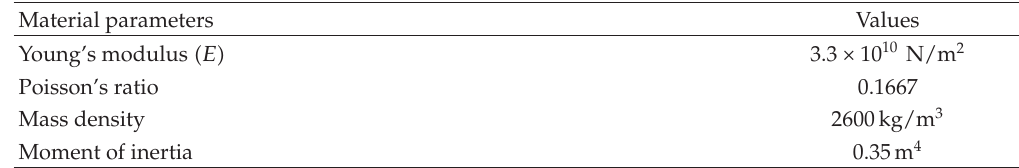
Figure 4: A bridge with multiple girders and element numbers. Table 1: Material properties of the simply supported